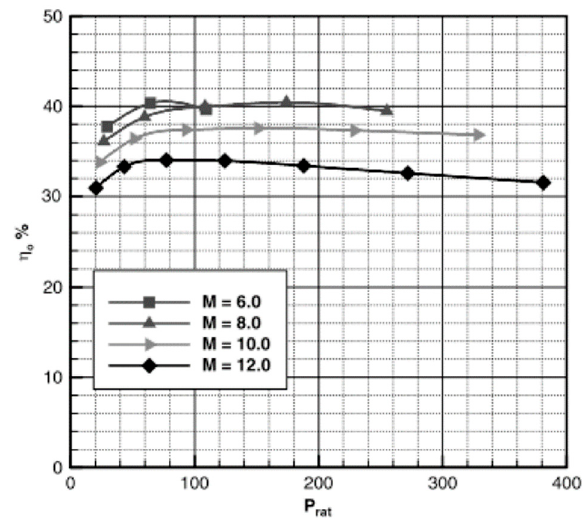
Figure 4. Overall scramjet efficiency at different pressure ratios and Mach number.